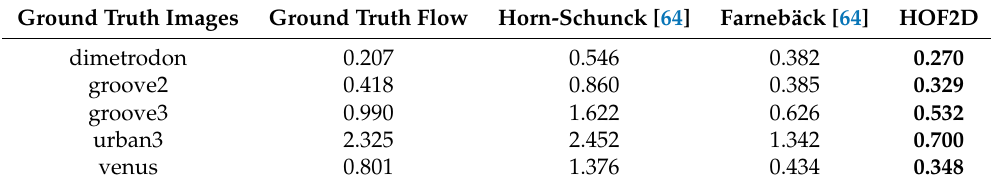
Table 3. Normal Interpolation Error Calculation.